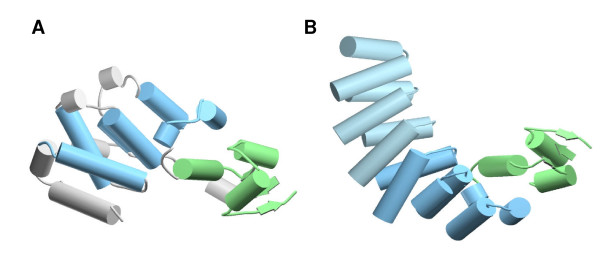
(A) shows the overall structure of eIF3k from the PDB-entry 1RZ4 [26] with β-strands and α-helices represented as ribbons and cylinders, respectively. Regions of the structure with sequence similarity to canonical PCI domain are rendered in colour. Regions belonging to the WH subdomain are shown in green, while conserved structure elements of the helical hairpin regions are shown in dark blue. The connection between β-strand 2 and 3 is not resolved and thus missing in 1RZ4. Other regions (extreme N- and C- termini, connecting helices between hairpins, unstructured regions) are shown in grey. (B) Model of a PCI protein with three additional helical hairpins upstream of the PCI domain. Within the PCI domains, only regions that can be modelled on the eIF3k template are shown. The N-terminal extension is shown in light blue, the other colours are as in figure 3a.